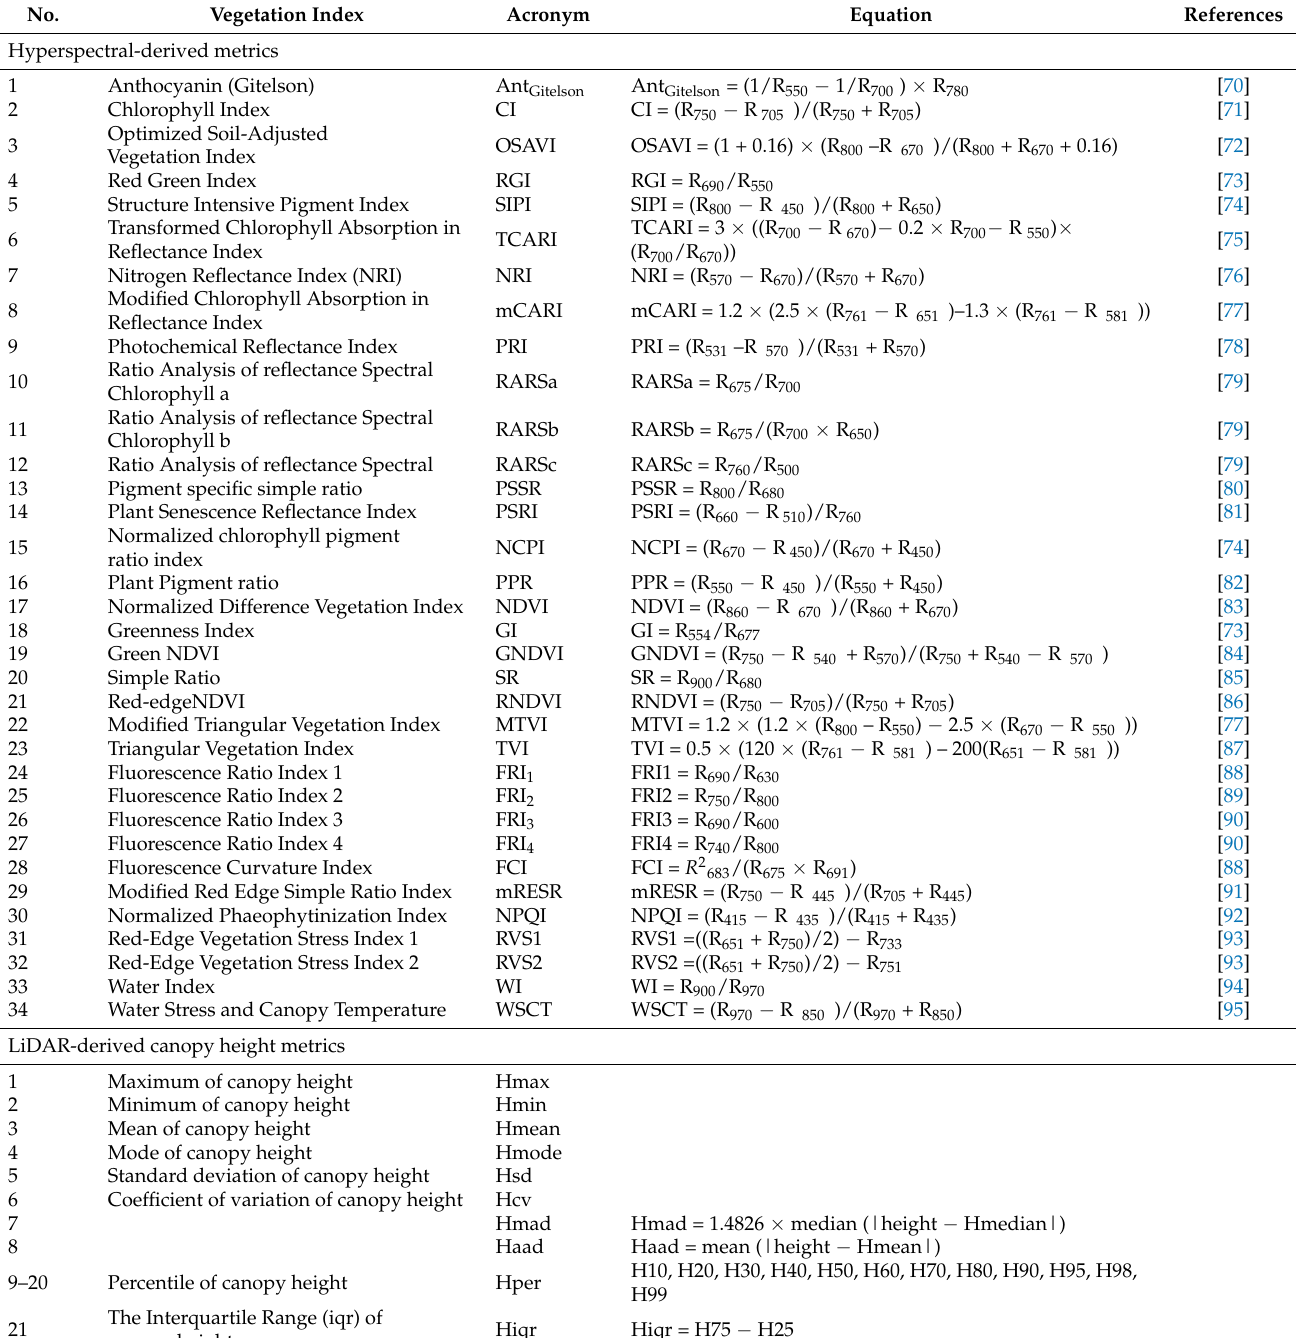
Table 4. Selected vegetation indices (VIs) across data